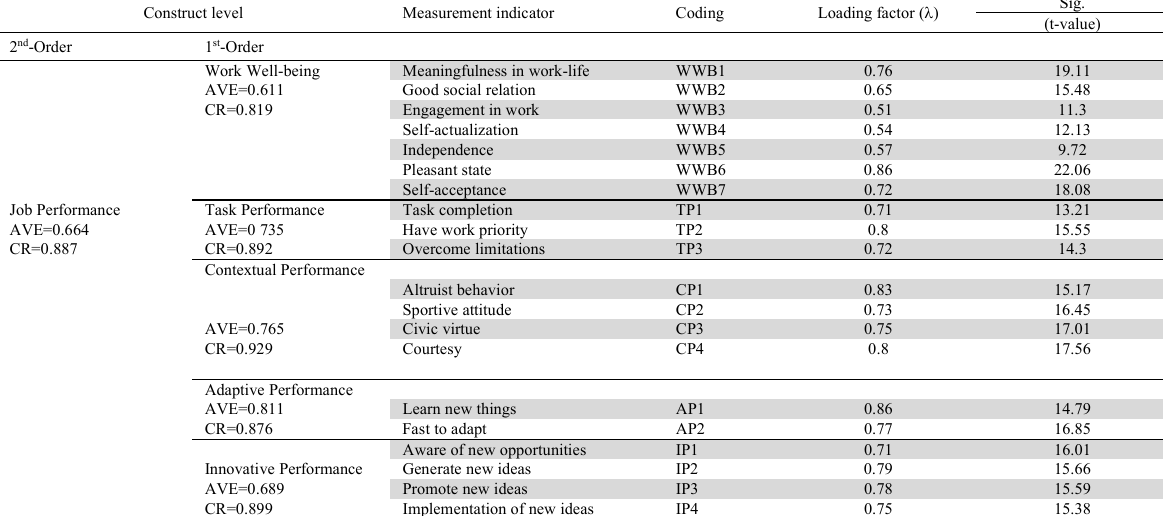
Measurement Model using Confirmatory Factor Analysis Construct level Measurement indicator